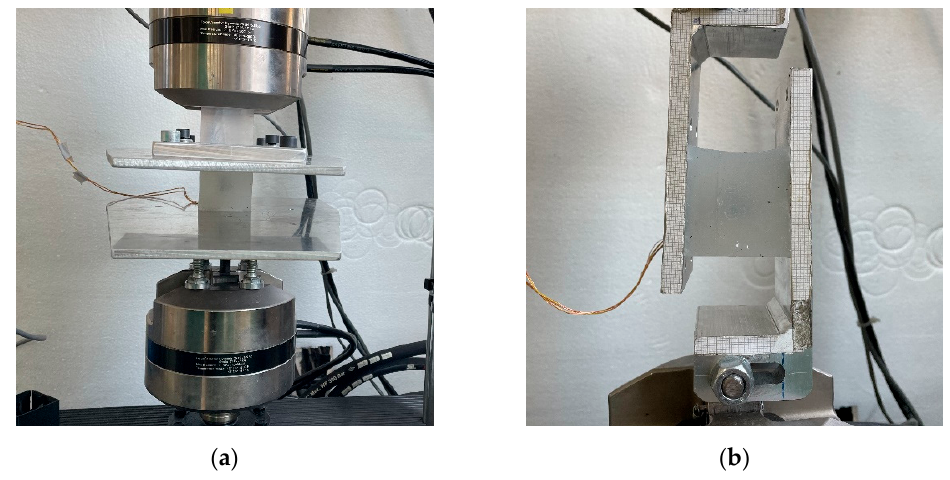
Figure 6. Test conditions: ( a ) Cube positioned for compression tests. ( b ) Cube positioned for shear tests.